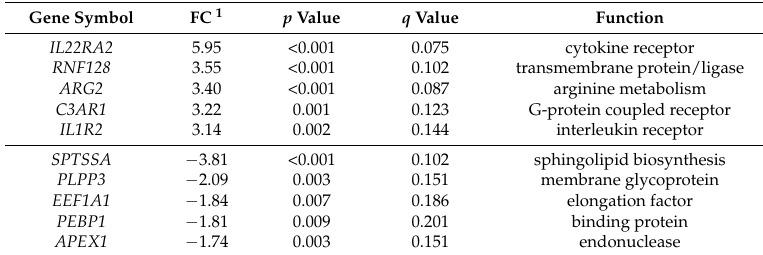
Table 3. Transcripts showing the highest differences in mRNA abundance between animals fed the L and H diets.